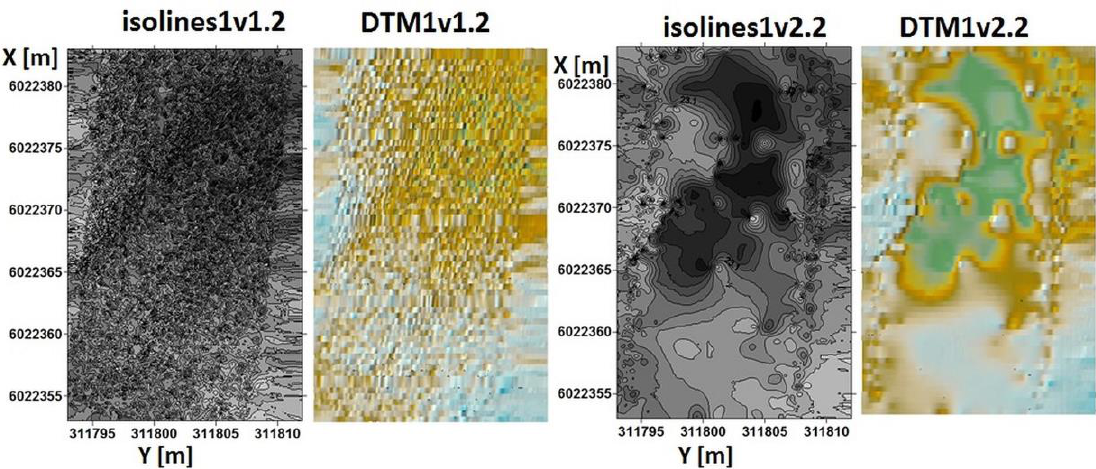
Figure 12. Isolines1v1.2 and DTM1v1.2, and isolines1v2.2 and DTM1v2.2 generated for strip 1 (po 1 ) by methodologies v1.2 and v2.2, respectively.